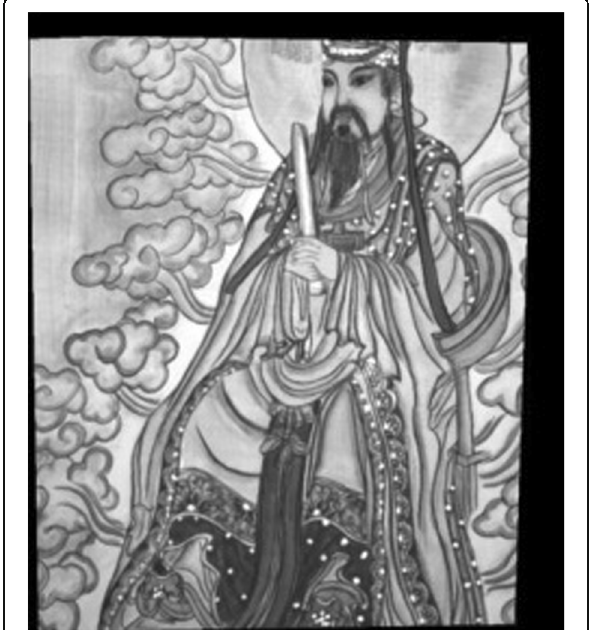
Fig. 4 The effect of matrix I obtained by superimposing